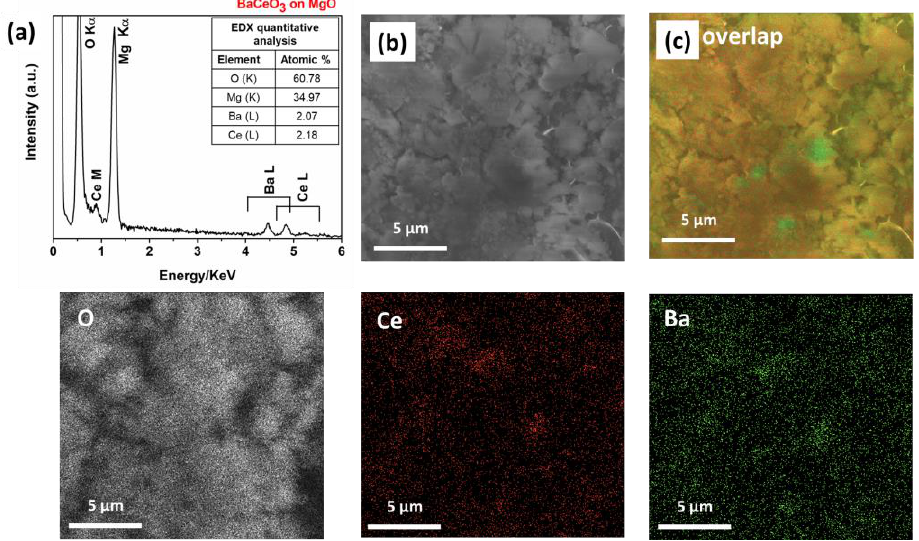
Figure 4. ( a ) EDX spectrum, ( b ) relative FE-SEM image, EDX elementary maps of O, Ce and Ba elements, and ( c ) overlapped map image of the BaCeO 3 film deposited on MgO at 950 °C.